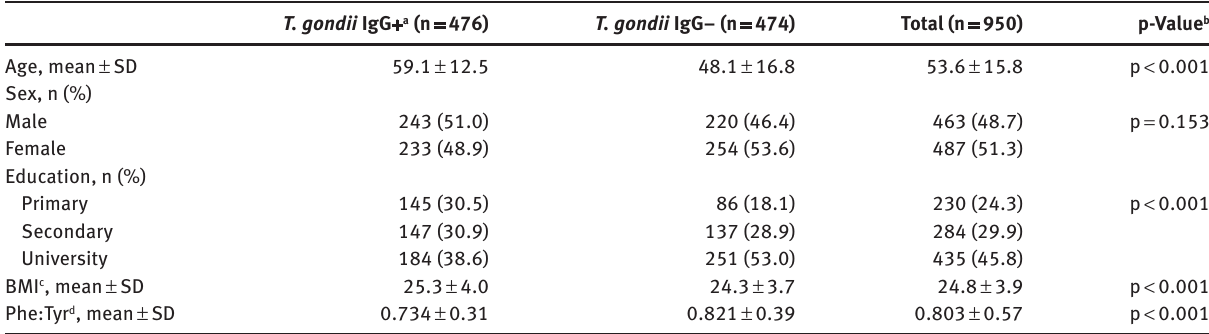
Table 1: Characteristics of study sample (n = 950) by T. gondii status. T. gondii IgG + a (n =